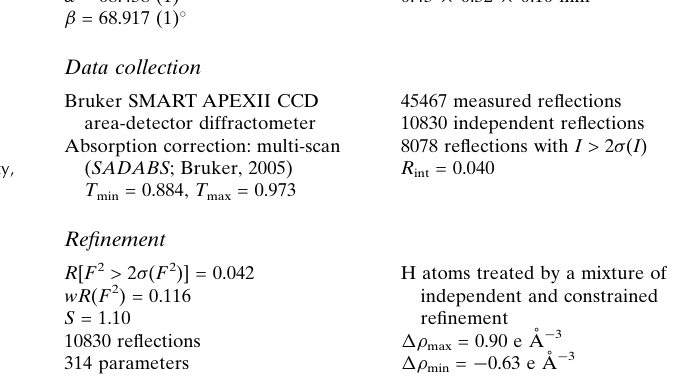
The asymmetric unit of the title compound, C 0.5H O, comprises two crystallograpically independent thio- 2 semicarbazone molecules ( A and B ) and a water molecule of crystallization. In each of the thiosemicarbazone molecules, intramolecular O—H (cid:1) (cid:1) (cid:1) O and N—H (cid:1) (cid:1) (cid:1) N hydrogen bonds form five-membered rings, producing S (5) ring motifs. Inter- molecular O—H (cid:1) (cid:1) (cid:1) S and N—H (cid:1) (cid:1) (cid:1) O interactions between molecule B and the water molecule form a six-membered ring, producing an R 22 (6) ring motif. Intermolecular N—H (cid:1) (cid:1) (cid:1) S hydrogen bonds form dimers involving pairs of both A and B molecules, which form R 22 (8) ring motifs. The angles between the aromatic ring and thiourea unit in the two molecules are 0.80 (6) and 3.28 (5) (cid:2) , which proves that each molecule is fairly planar. The crystal structure is stabilized by intermolecular ( (cid:3) 2) hydrogen bonds and C—H (cid:1) (cid:1) (cid:1) O ( (cid:3) 2) contacts to form a three-dimensional network.